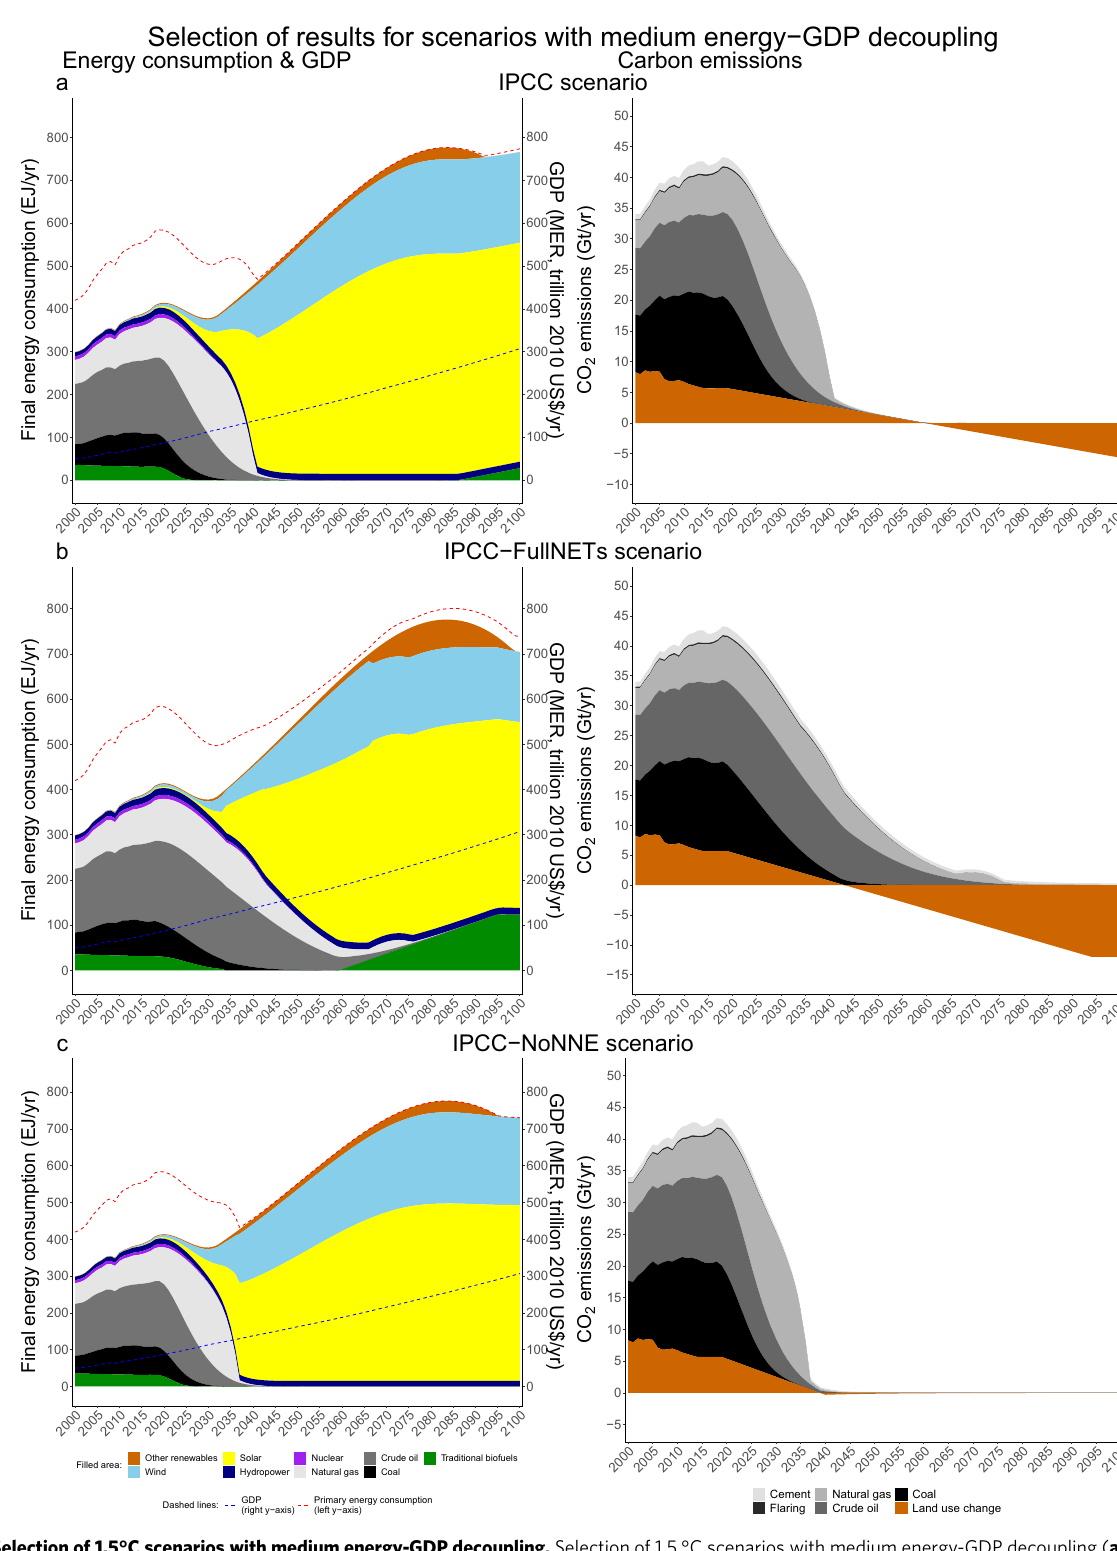
Fig. 3 Selection of 1.5°C scenarios with medium energy-GDP decoupling. Selection of 1.5 °C scenarios with medium energy-GDP decoupling ( a – c ). On the left, fi nal energy consumption (in EJ, left axis), aggregate primary energy consumption (in EJ, red dashed line, left axis) and GDP (MER, in trillion 2010 US$, blue dashed line, right axis). On the right, carbon emissions (in GtCO 2 /yr). The full collection of scenarios can be found in Supplementary Fig.